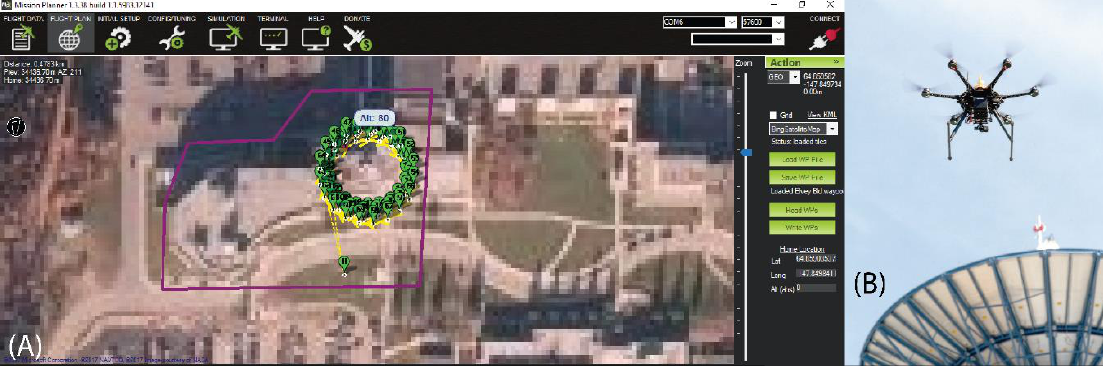
Figure 12. ( A ) Flight points for video survey of the Elvey 9 m satellite dish and ( B ) ACUASI Ptarmigan UAS; photo courtesy of Eric Engman, News-Miner © 2017. [24].